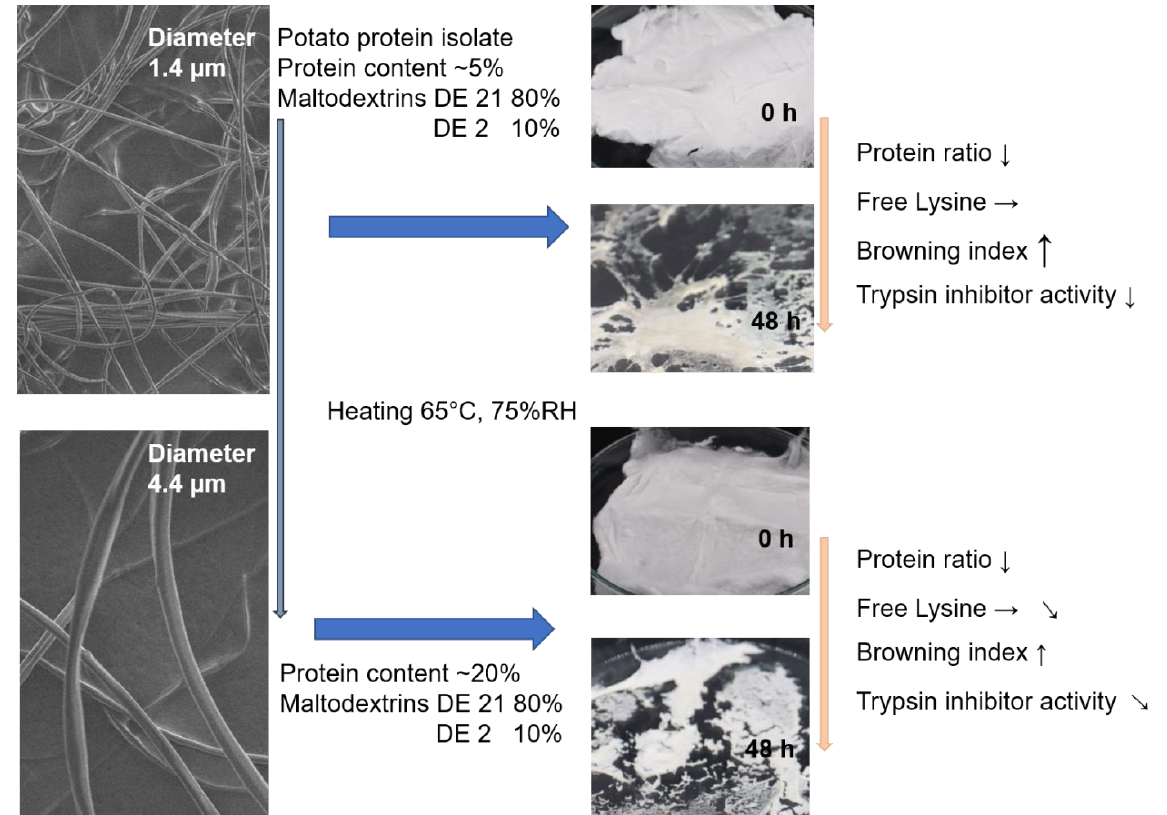
Figure 5. Schematic illustration of the study with respect to the addition of different concentrations of potato protein and the effects of electrospinning and thermal treatment on trypsin inhibitor activity.